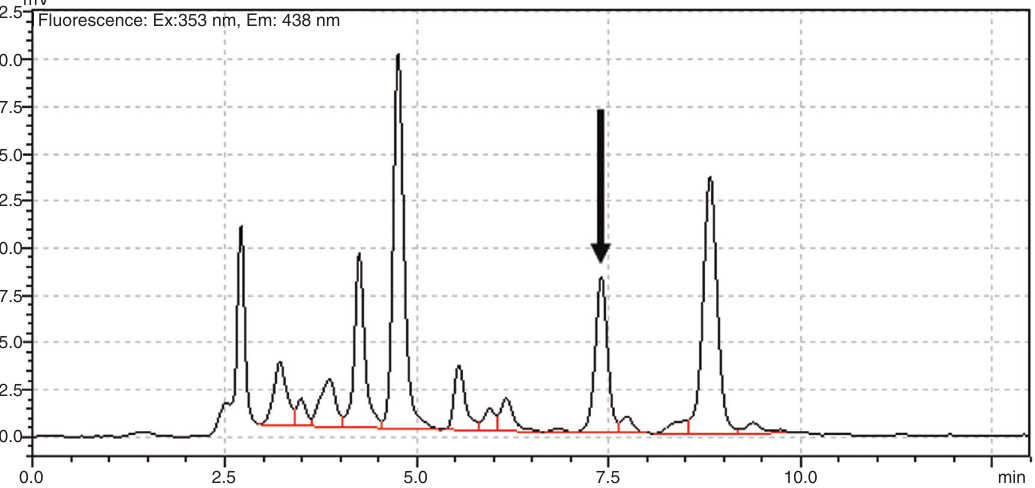
Figure 1 SCX chromatography analysis of neopterin in a control subject’s urine. The neopterin was detected by it native fluorescence (Ex 353 nm Em 438 nm) at 7.4 min as indicated by the arrow.